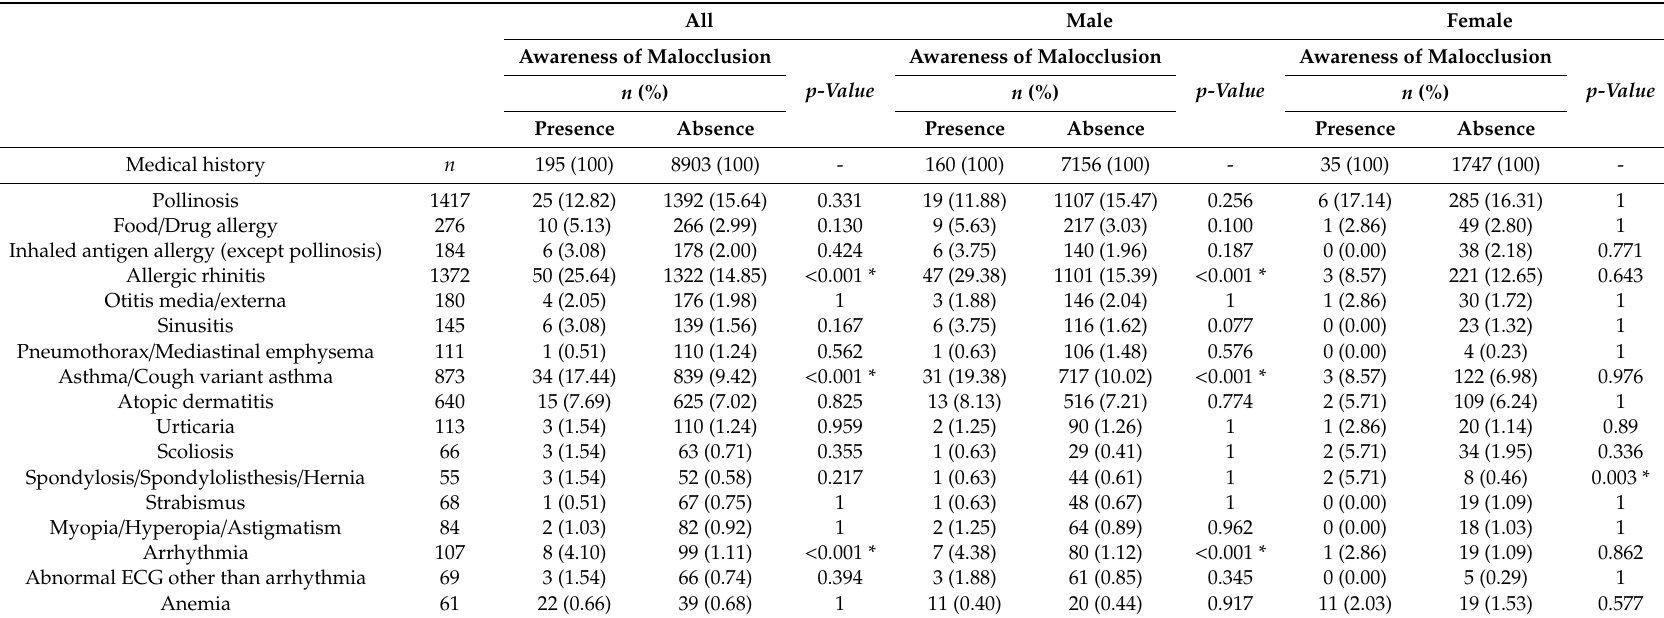
Table 2. Results of analyses of the associations between an awareness of malocclusion and common diseases in